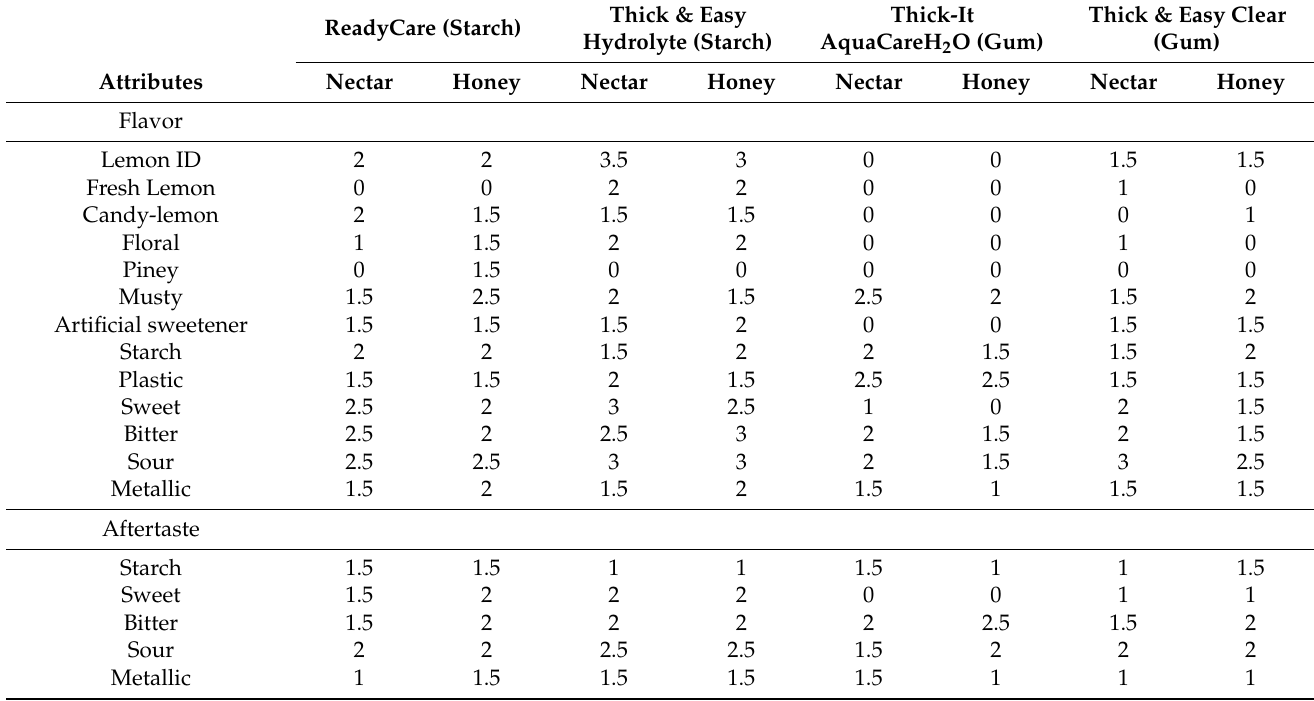
Table 2. Flavor and aftertaste attributes and intensities a of thickened water products b